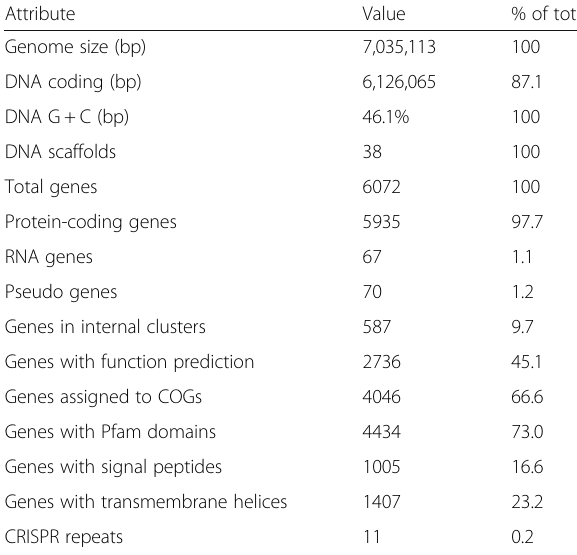
Table 3 Nucleotide content and gene count levels of